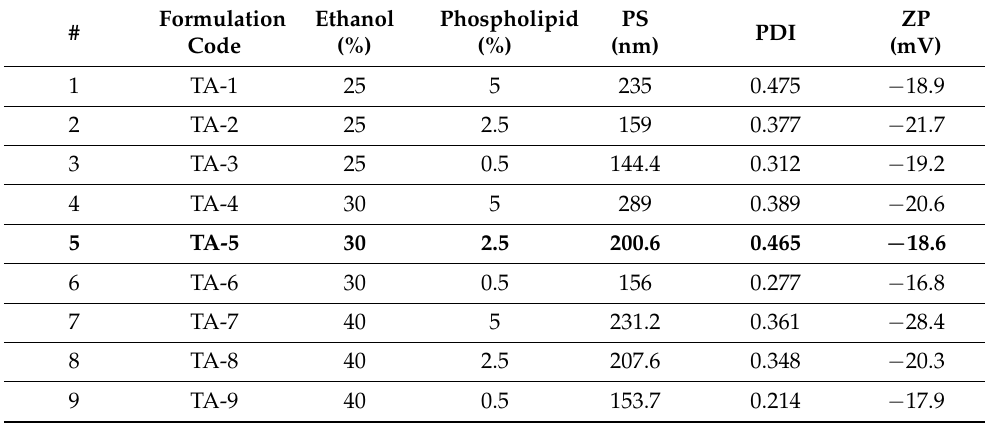
Table 2. Particle size (PS), polydispersibility index (PDI), and zeta potential (ZP) of the TAEG formulations (N =